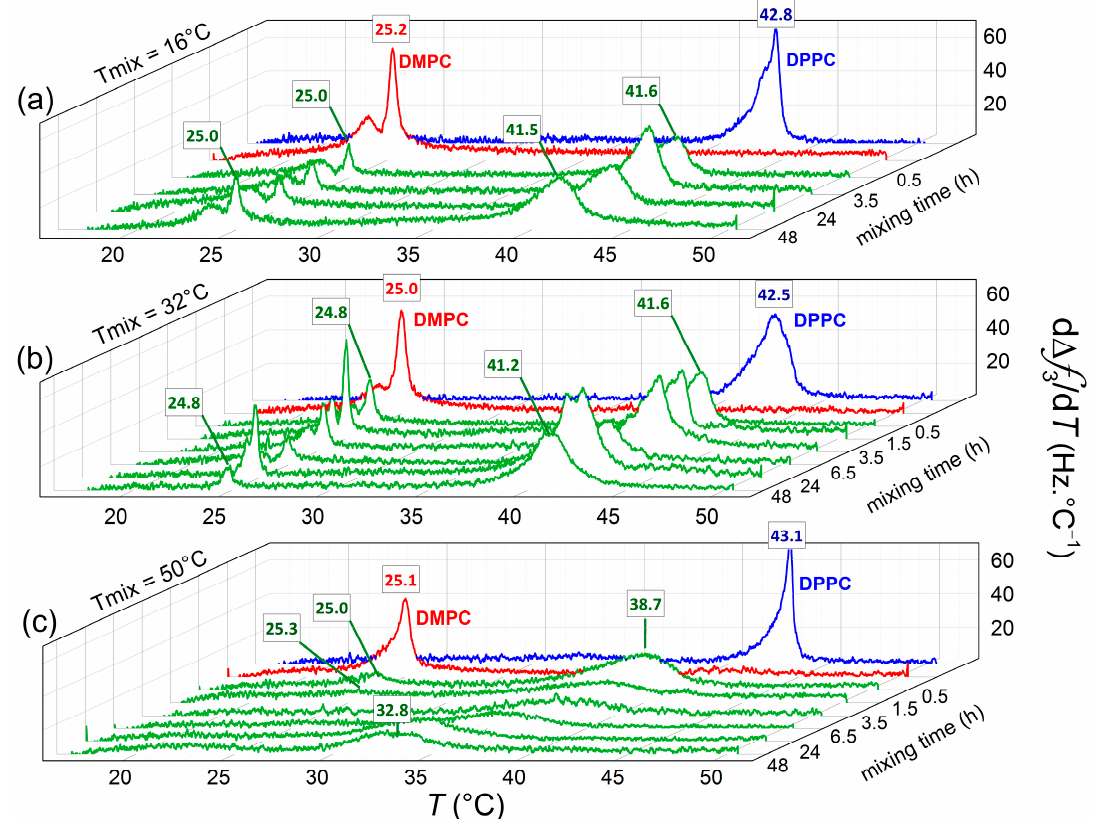
Figure 3. Dependence of the mixing time on the main phase transition parameters of adsorbed vesicles on Au-coated quartz surfaces. d Δ f /d T curves obtained upon heating demonstrate the phase transitions of samples at T = 16 °C ( a ), T = 32 °C ( b ), and T = 50 °C ( c ).